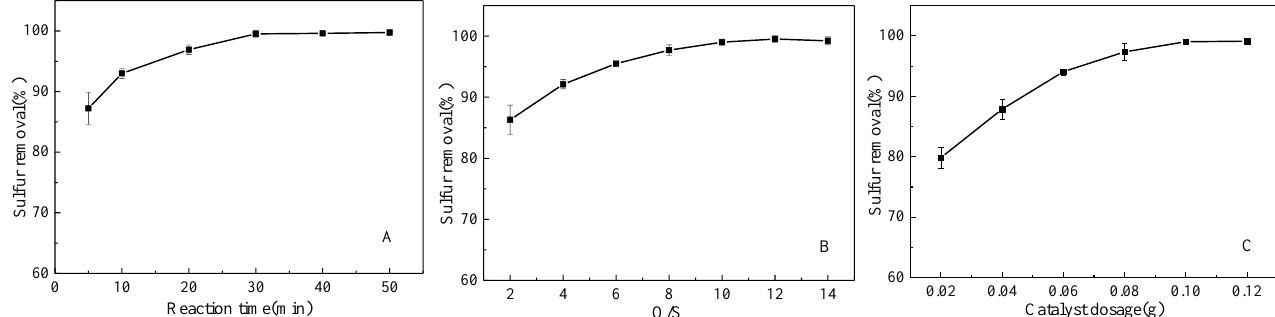
Figure 7. ( A ) Effect of reaction time (T = 25 °C, O/S = 10, and catalyst dosage = 0.1 g/10mL). ( B ) Effect of O/S molar ratio (T = 25 °C, t = 30 min, and catalyst dosage = 0.1 g/10mL). ( C ) Effect of catalyst dosage (t = 30 min, T = 25 °C, and O/S = 10).